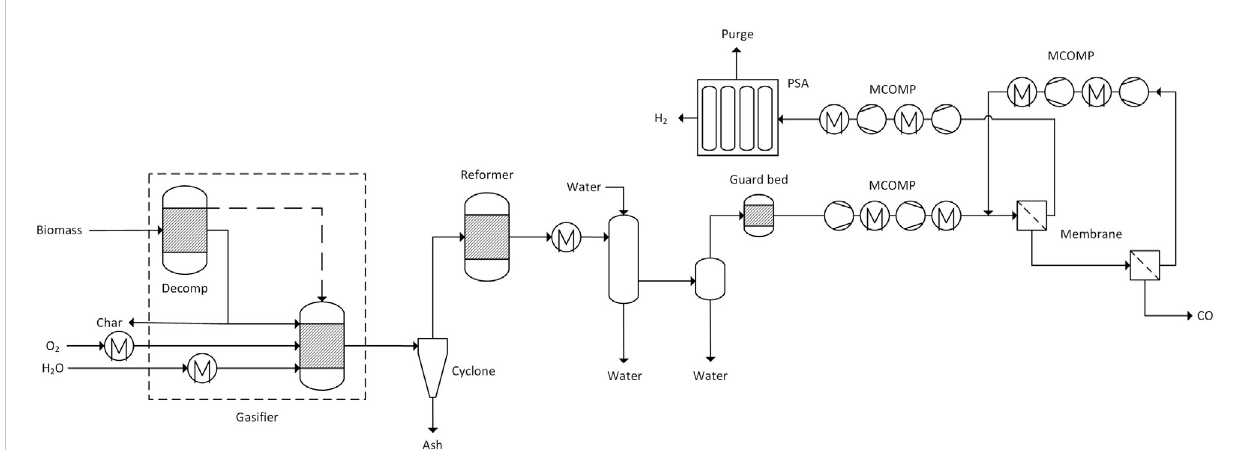
FIGURE 2 Flowsheet of the gasi fi cation and gas conditioning section including CO and H 2 separation. (dashed lines represent heat fl ows, solid lines are material fl